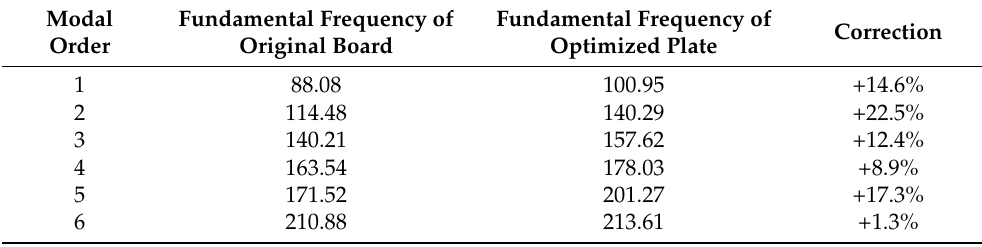
Table 6. Comparison of the fundamental frequency of the board before and after optimization.